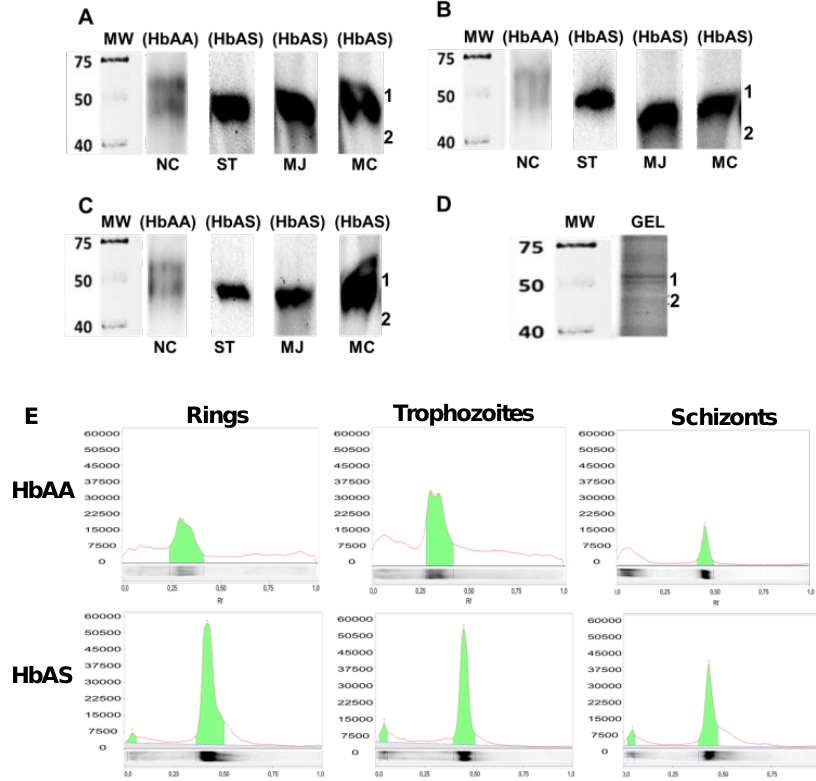
Figure 4. Profile of P. falciparum protein carbonylated bands at different asexual stages. Panels show protein oxidized profiles obtained at rings ( A ), trophozoites ( B ) and schizonts ( C ) from HbAS control and HbAS carriers. NC: HbAA control. ST, MC, and MJ: HbAS donors. Panel D shows the preparative polyacrylamide gel stained with Coomassie Blue Brilliant (CBB) for schizont ’ s proteins that match with the oxyblots. Of parasite proteins 2.5 μg derivatized with DNPH were used in oxyblots, while 50 μg were electrophoresed in preparative SDS -PAGE. Panel E displays densitograms of carbonylated protein bands detected in oxyblots across the erythrocytic cycle for HbAA control and ST HbAS donor. Densitograms were analyzed with ImageLab software ® to determine variations in the intensity of the signal for the detected carbonylated bands (panel E, Figure 4). For parasite proteins from erythrocytes, HbAA recorded the trophozoites stage as the most oxidizing, while the ring stage was the more carbonylated phase in HbAS proteins. This behavior reinforces the result obtained previously by dot-blot.